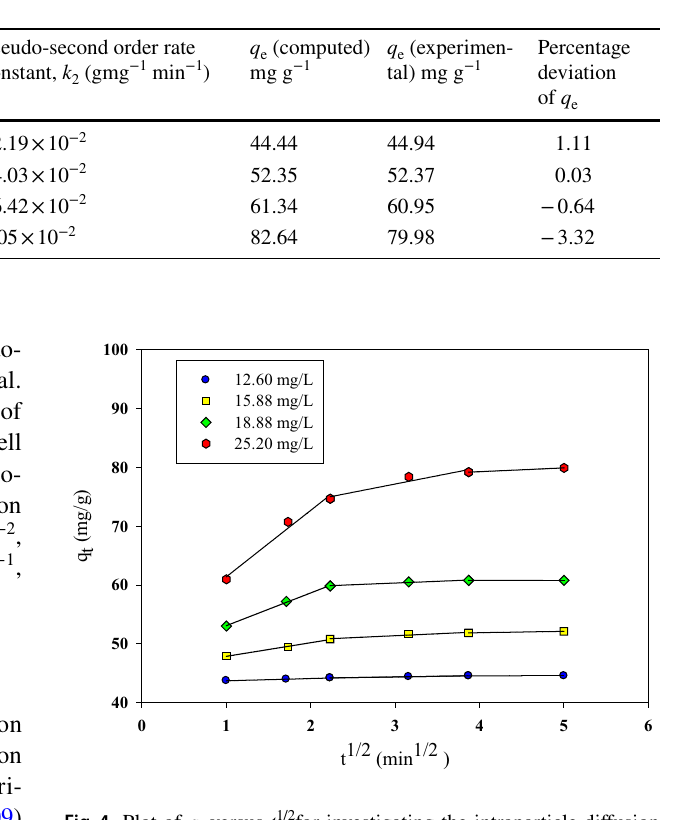
Fig. 4 Plot of q t 1/2 for investigating the intraparticle diffusion t versus mechanism for adsorption of different concentration of methylene blue solutions on coconut coir dust